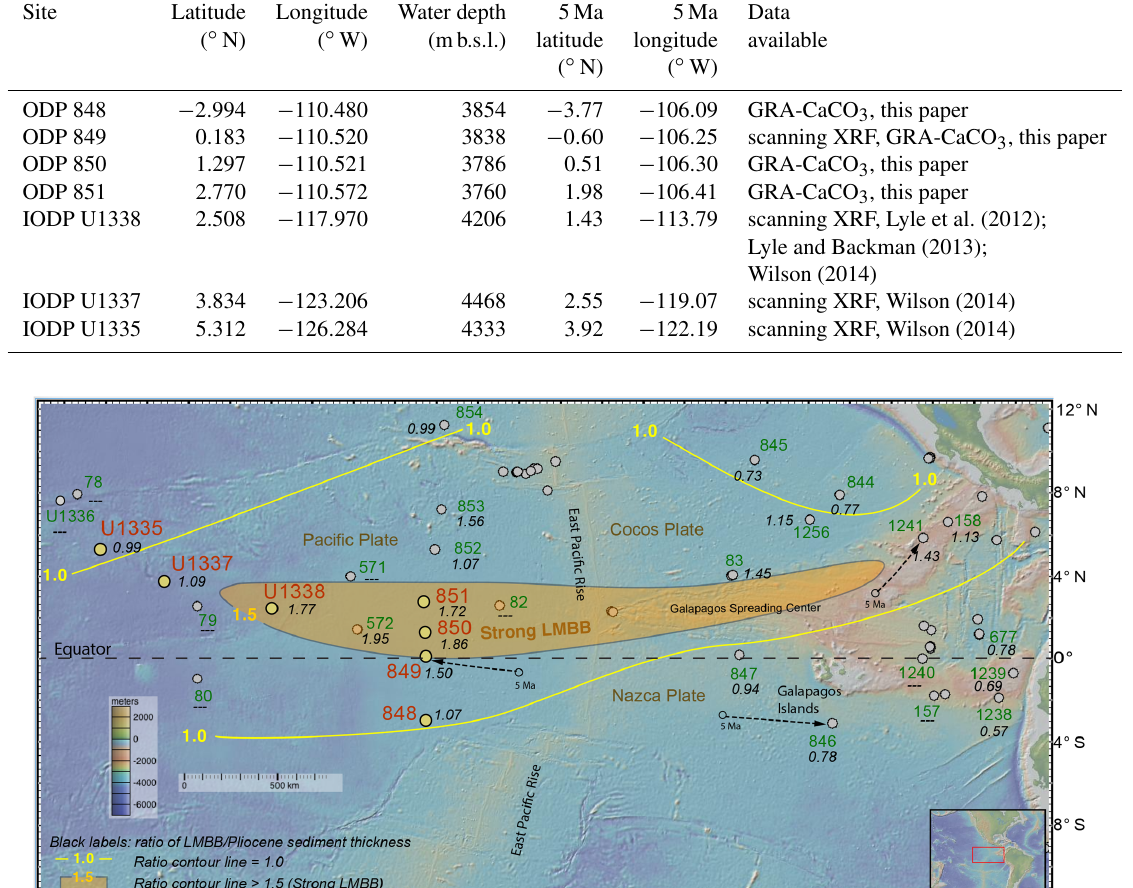
Table 1. Drill sites investigated in this study.